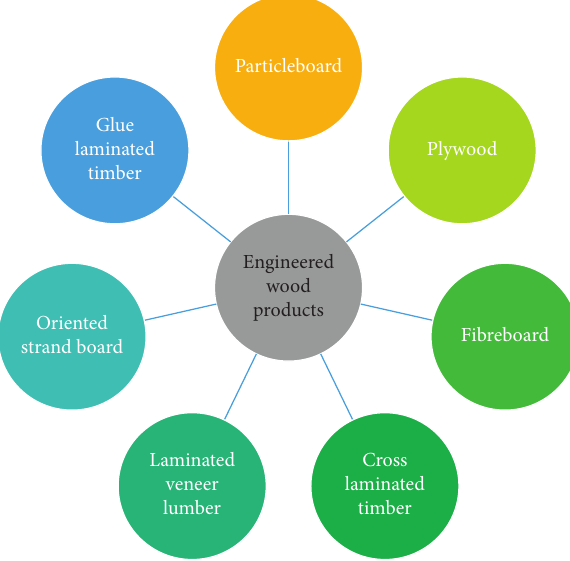
Figure 3: Types of engineered wood